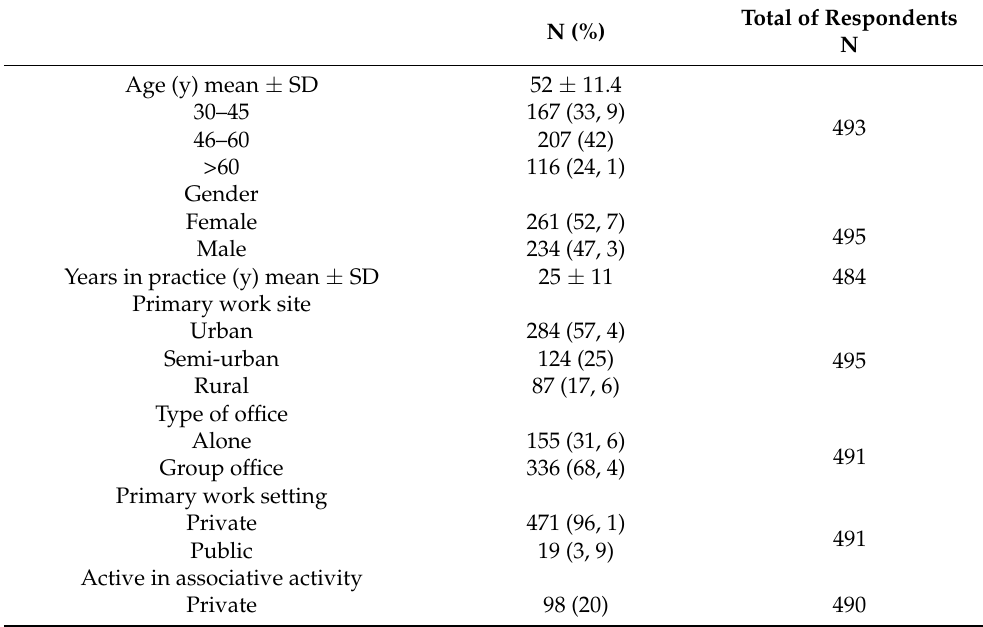
Table 1. Demographic characteristics of respondents, N (%). Not all categories represent the total number of respondents (N = 497) due to missing